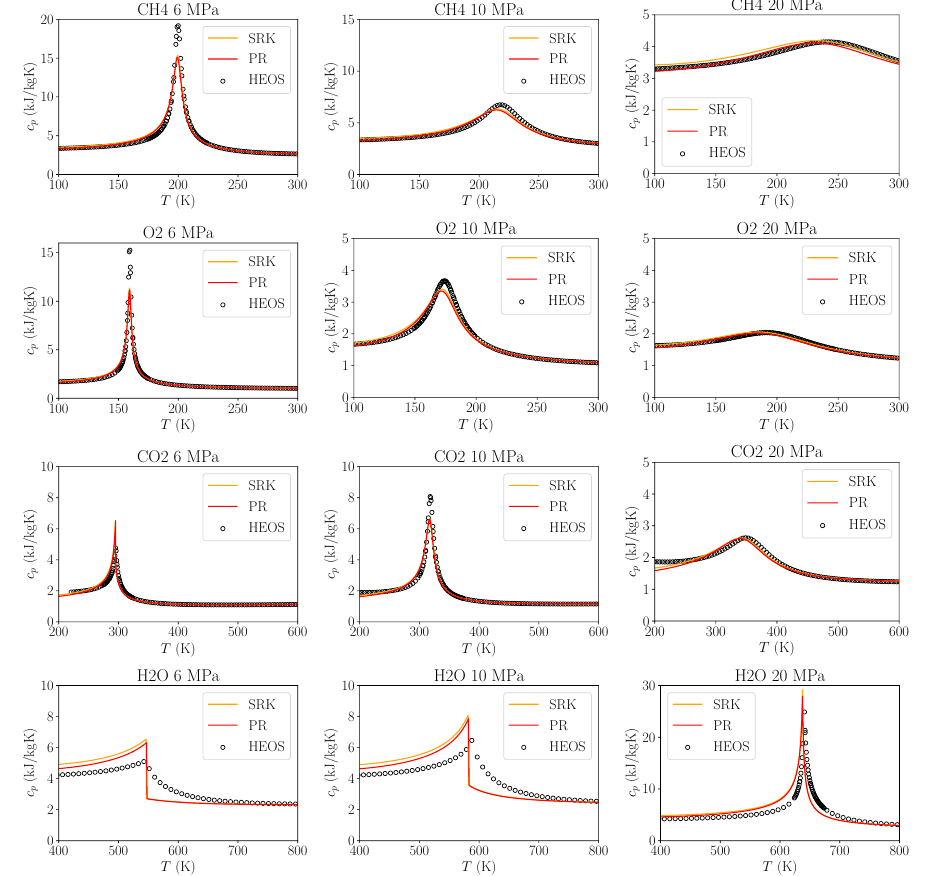
Figure 5. Comparison of Peng–Robinson and Soave–Redlich–Kwong EOS to reference data for isobaric specific heat capacity c p of, from top to bottom, methane, oxygen, carbon dioxide, water; at three different pressures from left to right p = [ 6,10,20 ]